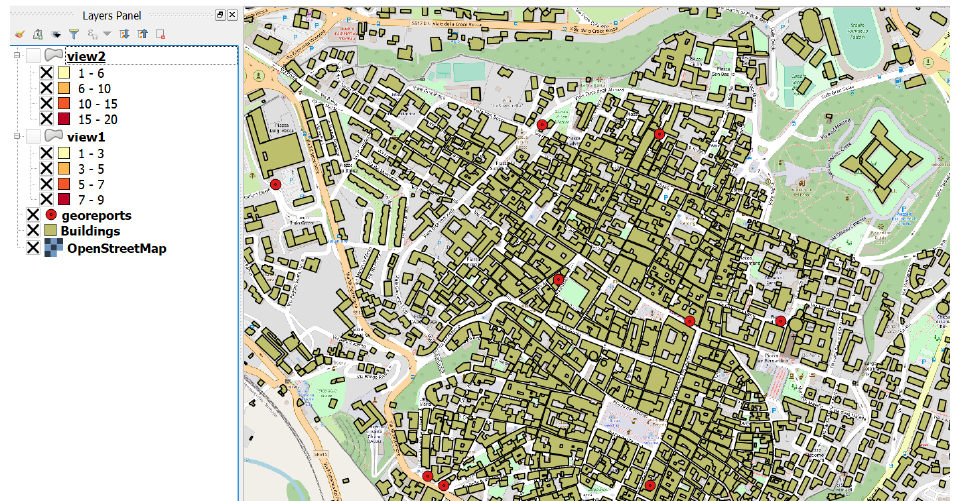
Figure 25. The location of few damaged buildings in the city of L’Aquila on top of an